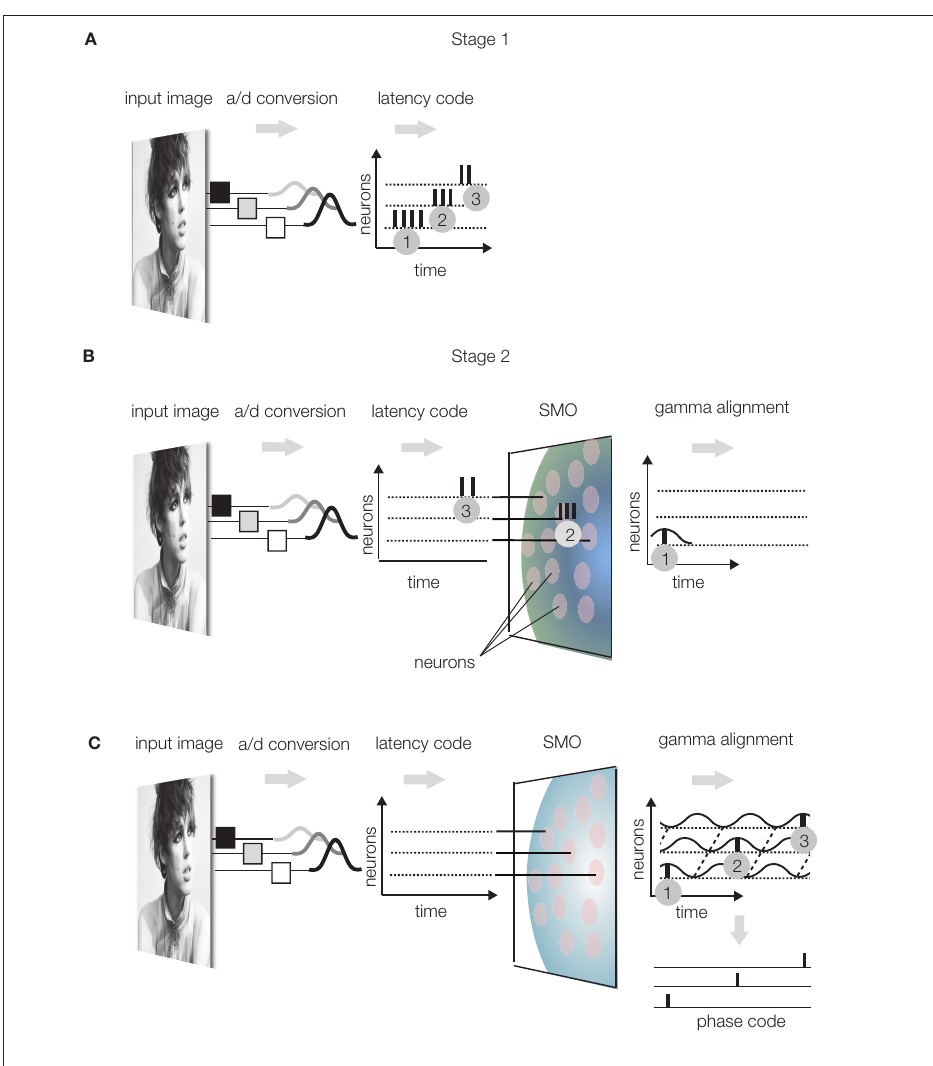
Figure 3 | Sensory encoding. (A) Stage 1: Luminance changes in the visual input evoke bursts of APs in the retina, where the burst frequency is proportional and burst latency is inversely proportional to the luminance. Bursts are numbered in the order of generation time. (B) Stage 2: bursts are filtered by the SMOs of a layer of neurons. The SMOs propagate within the transversal plane with a radial spread and depolarize the neurons in a specific order. Only single AP components of bursts will pass the layer, specifically those APs that coincide with the SMO peaks of the given neuron. Gray patches represent neurons with SMOs. As a result, APs will be aligned to the intrinsic SMO of these neurons.